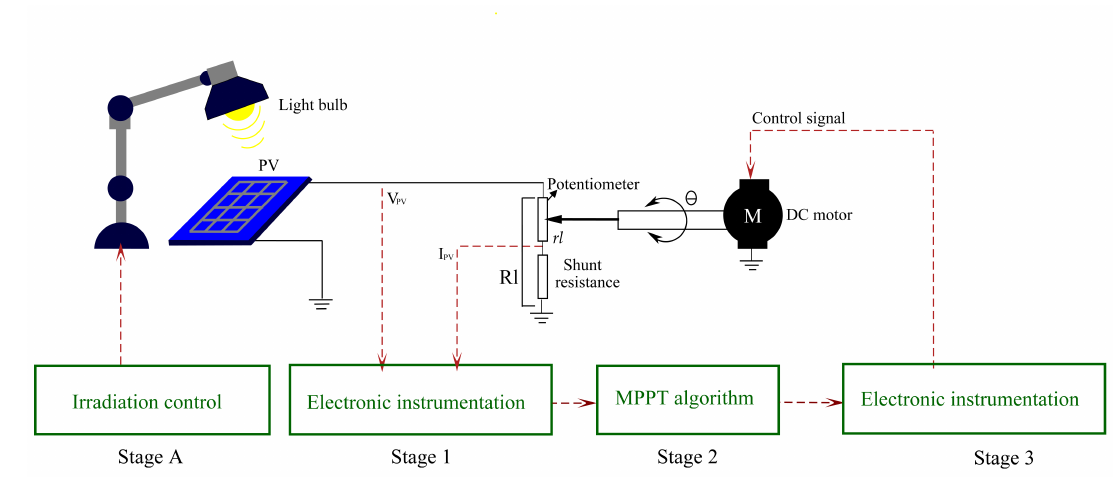
Figure 7. Overview scheme of the experimental